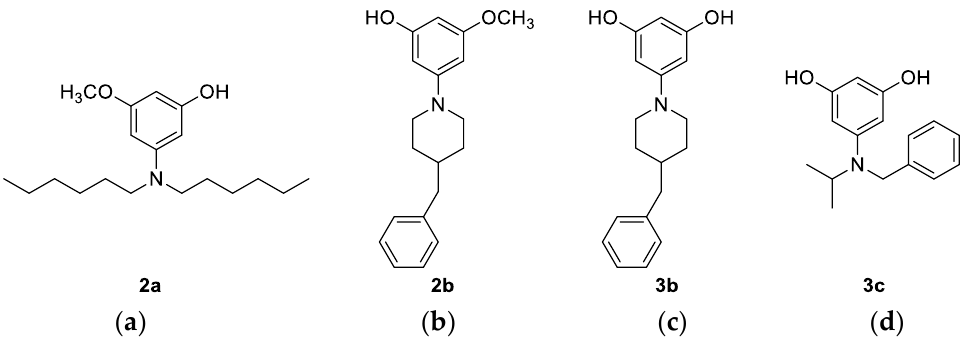
Figure 3. Structures of the derived products: ( a ) 3-(dihexylamino)-5-methoxyphenol ( 2a ): 20%; 1